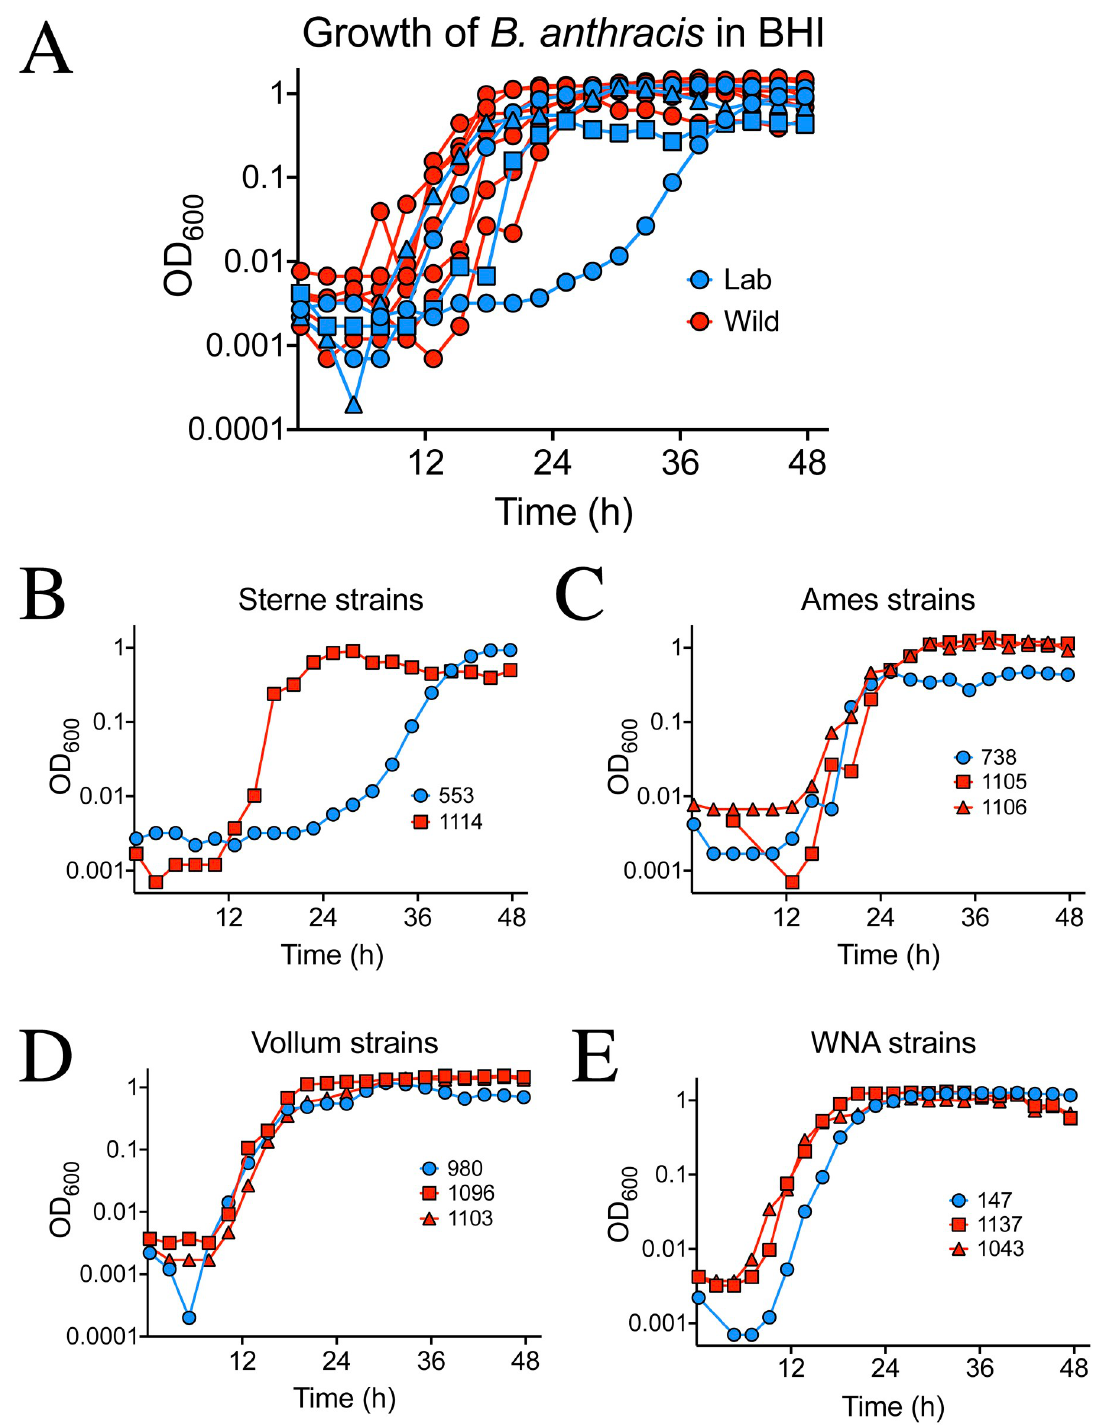
Fig 2. Growth analysis of wild and lab strains of B . anthracis . Growth rate analysis of B . anthracis was carried out in a Tecan Sunrise 96-well plate shaking incubator in BHI broth. A), Growth curves of all strain data. Red curves indicate wild strains of B . anthracis and blue lines indicate common laboratory strains. B), Our wild Sterne-like B . anthracis strain UF01114 (red) that is pXO2 − has a much shorter lag-phase and enters log phase well ahead of our Sterne laboratory strain (blue). In C), the wild Ames-like strains (red circles and red triangles) achieve a higher final cell density than our Ames laboratory strain (blue). In D), a wild Vollum-like strain, UF01096 (red circles), has a higher rate of logarithmic growth compared to our Vollum lab strain (blue circles). Strain, UF01103 (red triangles), grows the same as the Vollum-lab. In E), our Western North American (WNA) wild strains (red circles and triangles) enter logarithmic growth earlier and at a steeper rate than WNA lab strain UF00147 (blue). The mean of two OD 600 measurements every 2 h are shown.